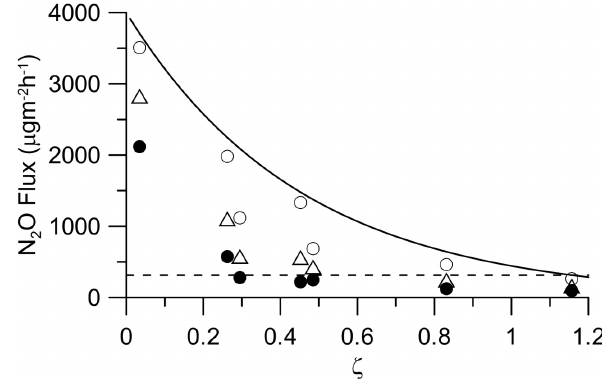
Figure 11. Dependence of the calculated fluxes on the stability ς of the boundary layer ( ς >0). The flux measurement based on the ‘similarity’ approach (open circles), MOST parameterized flux-gradient theory (‘parameterized’ approach, closed circles), and measured friction velocity u * flux-gradient theory (‘measured u * ’ approach, open triangles) is indicated. The dashed line indicates the chamber-measured flux (see text). The line shows the upper emissions bound.